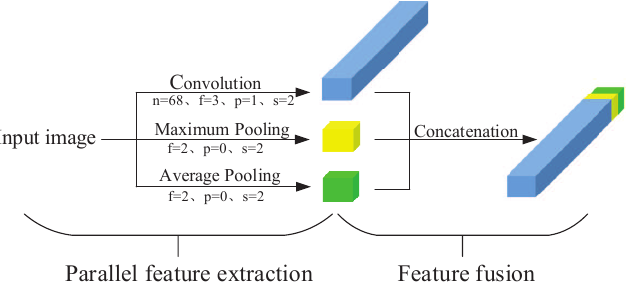
Figure 5. Parallel feature extraction structure.